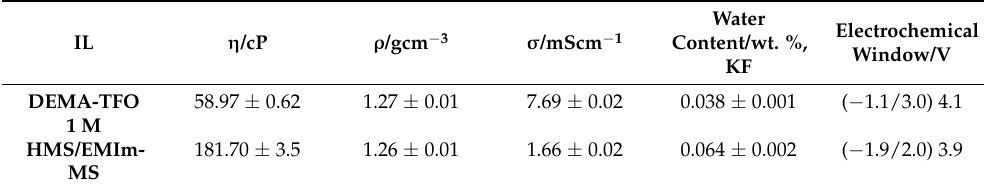
Table 1. Physicochemical properties of ILs and its mixtures with parent superacid. For the electro- chemical window, the values in brackets are: (cathodic limit /anodic limit). IL η /cP ρ /gcm − 3 σ /mScm − 1